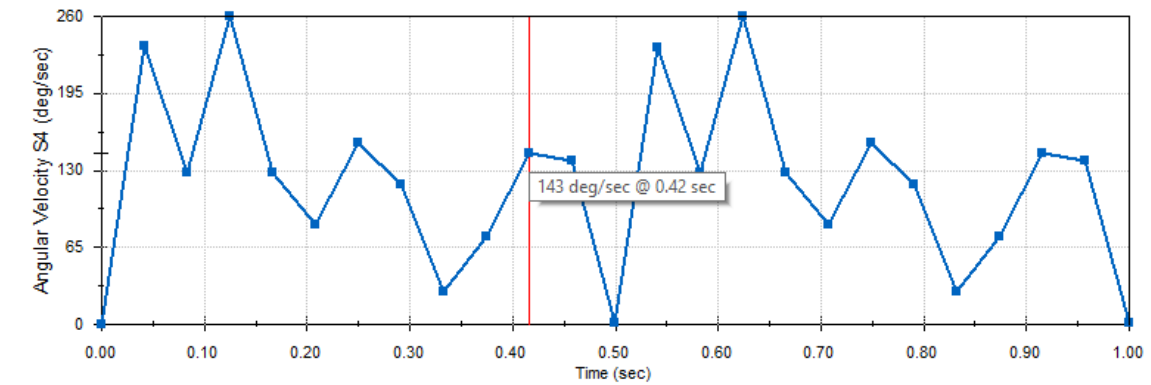
) angular velocity 4